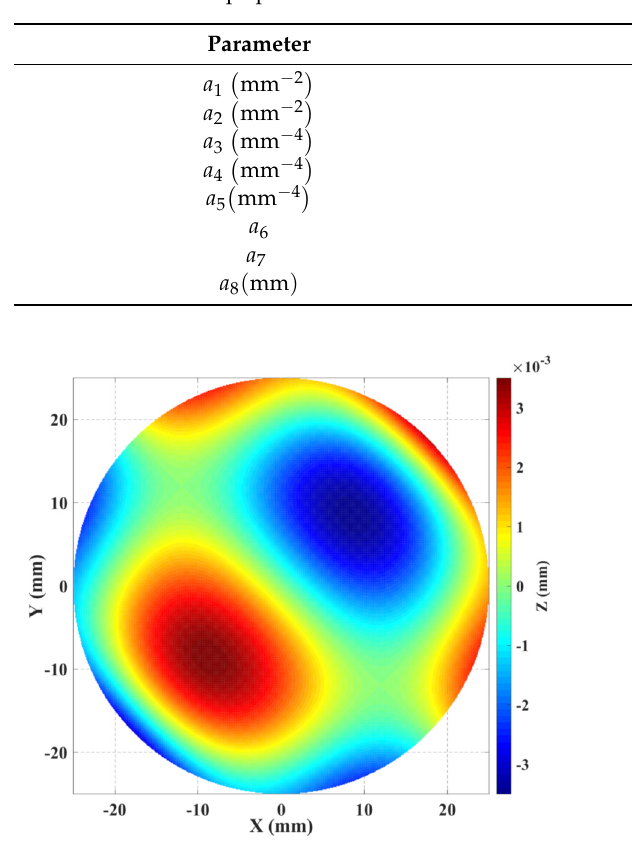
Figure 5. ( a ) Design of the thermo-invariant material measure for aspherical surface (TIMM-1), ( b ) bottom: y = 0 plane. The nominal shape is contained inside two similar aspherical shapes forming the artificial envelope, which represent the form error. Table 2. Nominal shape parameters for TIMM-2.